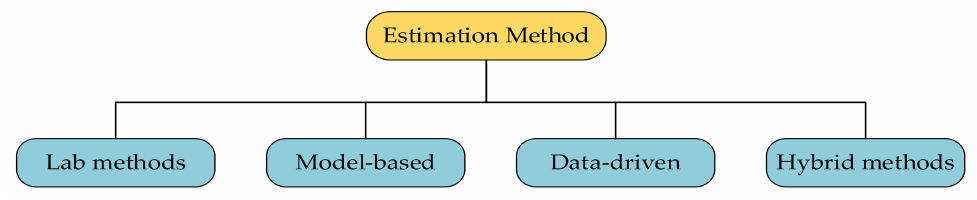
Figure 3. SOC-estimation methods classification. Table 2. Advantages and disadvantages of SOC-estimation methods for Li-ion